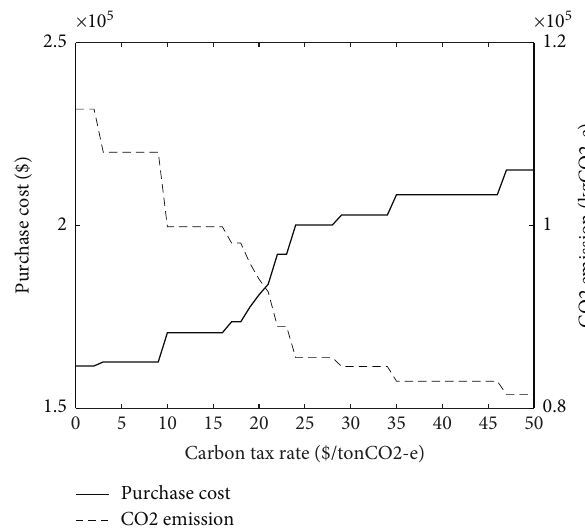
Figure 7: Purchase cost and CO carbon tax